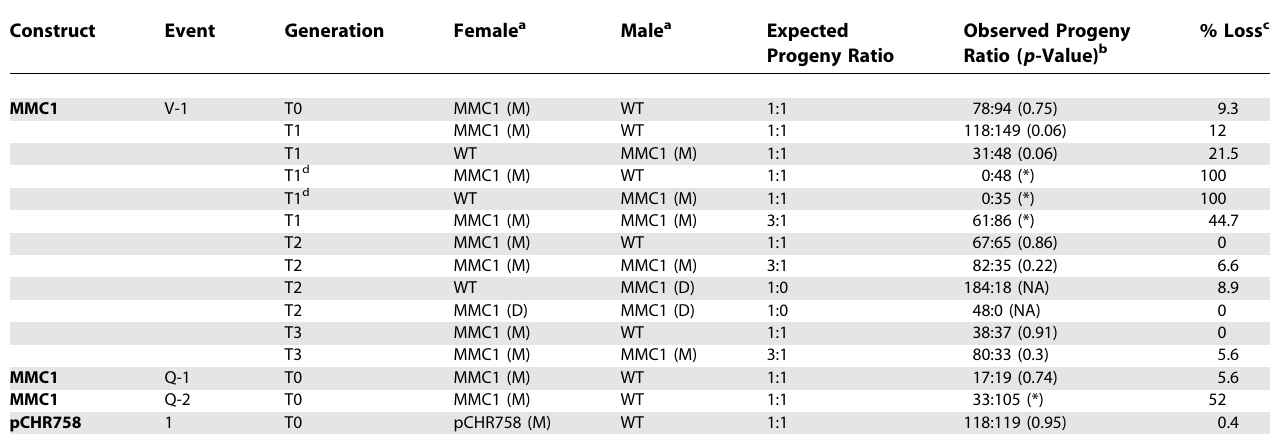
Table 3. Meiotic Inheritance of MMC1 Construct Event Male